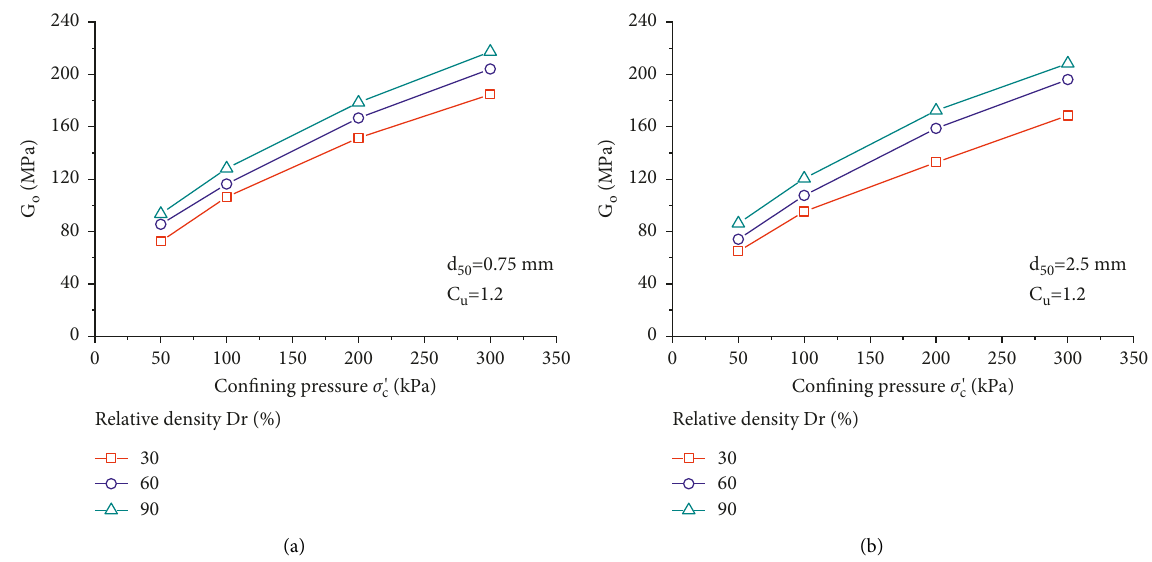
� 1.2 at varying densities. (a) d